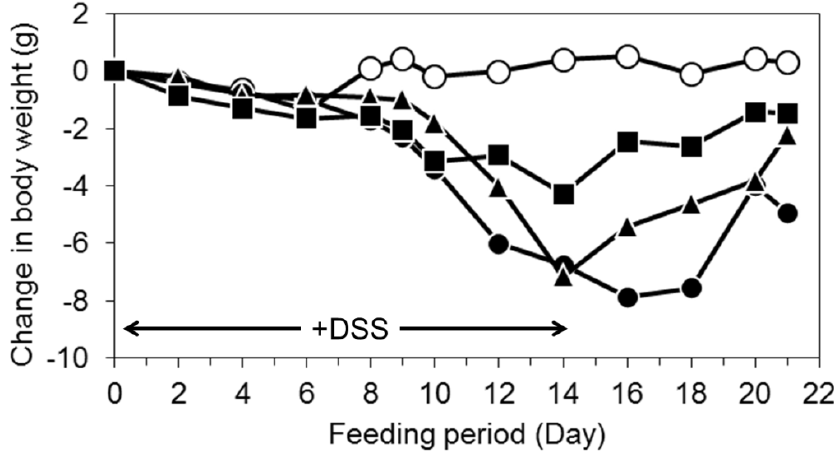
Figure 2. The effect of the oral intake of whey protein concentrates on body weight of dextran sodium sulfate (DSS)-treated mice. Opened circles, normal mice without DSS treatment; filled circles, DSS-treated mice; filled triangles, mice treated with DSS + HWPC feed; filled squares, mice treated with DSS + LWPC